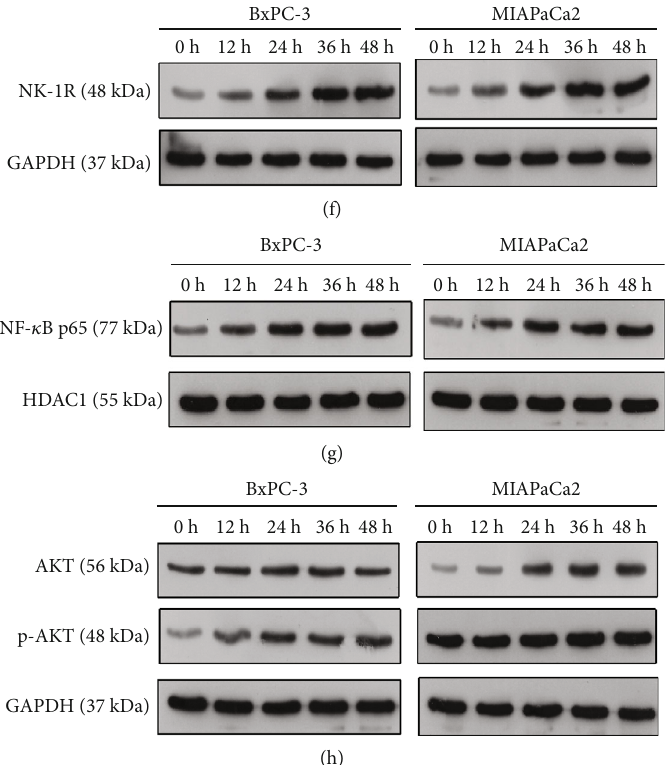
Figure 3: Selection of the optimal SP concentration and treatment time. (a – d) The optimal SP concentration was selected after testing concentrations of 0, 10, 25, 50, 100, and 150 nmol/L. (a) NK-1R gene expression at each SP concentration. (b – d) The levels of NK-1R, NF- κ B p65, AKT, and p-AKT protein expression at each concentration of SP. (e – h) The optimal SP treatment time was selected after incubation for 0h, 12h, 24 h, 36 h, and 48h, respectively. (e) NK-1R gene expression at each SP treatment time. (e – h) The levels of NK- 1R, NF- κ B p65, AKT, and p-AKT protein expression at each SP treatment time. ∗ P < 0 : 05 , ∗∗∗ P < 0 : 001 vs. 0nmol/L group or 0 h